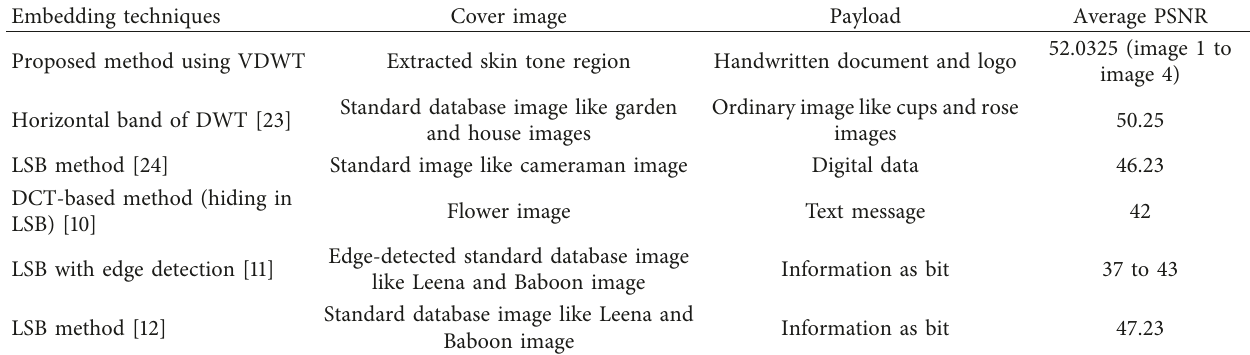
Table 3: Comparison of the proposed and existing